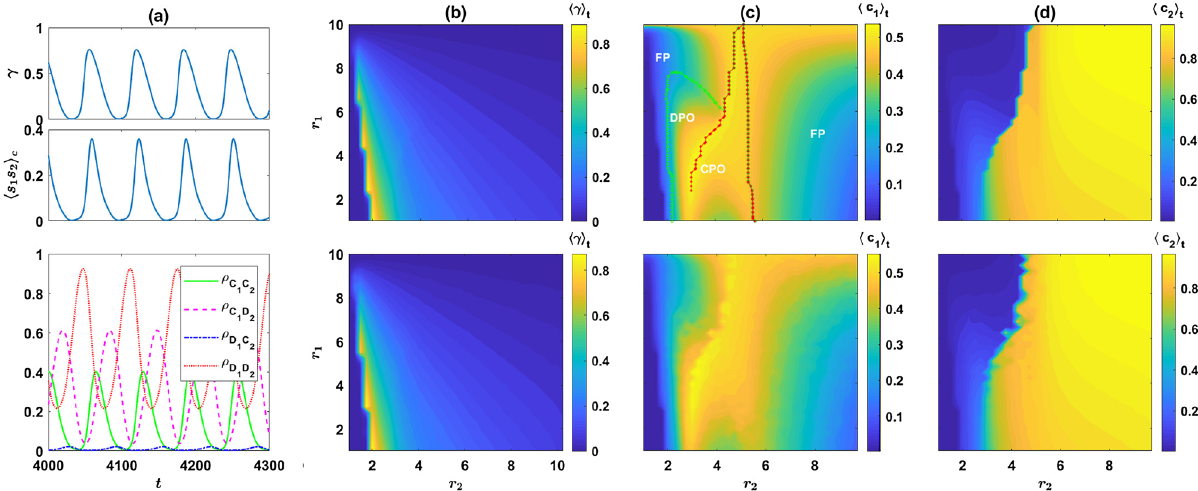
Figure 5. Evolution of cooperation and consistent personalities in assortative public goods game. ( a ) The time series of the personality consistency measure γ (top), and the connected correlation function between the strategies of the individuals in the two rounds (cid:31) s 1 s 2 (cid:30) t (middle). For comparison, the densities of different strategies are plotted in the bottom panel. Both measures always remain non-negative. This shows individuals evolve consistent personalities in the two rounds. ( b ) The contour plot of the time average personality measure (cid:31) γ (cid:30) t , in r 1 − r 2 plane. γ remains non-negative in the whole phase diagram, which indicates consistent cooperative and defective personalities evolve. ( c ) The contour plot of the time average cooperation level in the first round � ρ C 1 � t = � ρ C 1 C 2 + ρ C 1 D 2 � t . The phase boundaries are plotted in the top panel as well. Interestingly, the cooperation level in the first round is maximized on the singular transition between the two periodic orbits. ( e ) The contour plot of the time average cooperation level in the second round � ρ C 2 � t = � ρ C 1 C 2 + ρ D 1 C 2 � t . (cid:30) t increases with increasing r 2 . Here, g = 10 , ν = 10 − 3 , c = 1 , and π 0 = 2 . In ( a ) numerical solutions of the (cid:31) ρ C 2 replicator dynamics are used. In ( b )–( d ), top panels result from numerical solutions of the replicator dynamics, and bottom panels result from simulation on a population of size N = 10,000 . The replicator equations are solved for T = 5000 time steps starting from a homogeneous initial condition, and the time averages are taken over the last 2000 steps. The simulations are performed for T = 4000 steps starting from a random assignment of strategies, and the averages are taken over the last 3500